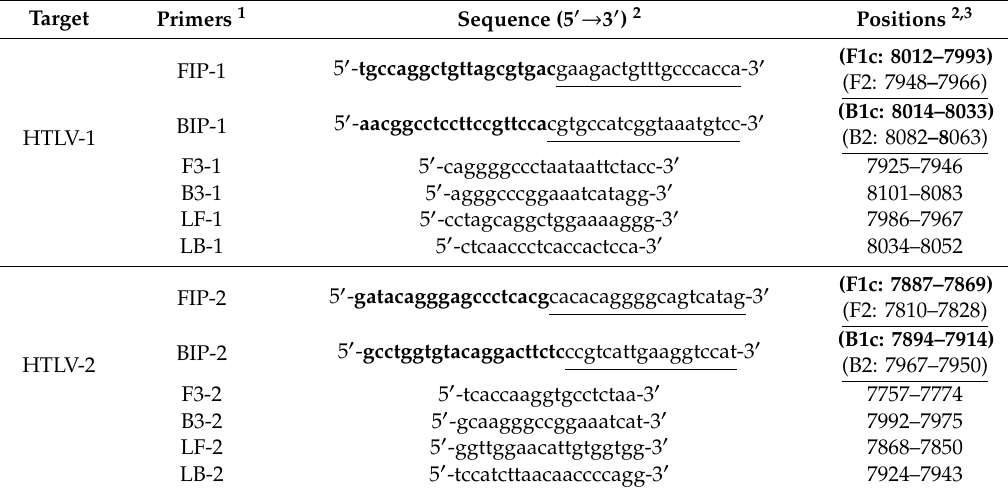
Table 1. Loop-Mediated Isothermal Amplification (LAMP) primers for human-T lymphotropic viruses HTLV-1 and